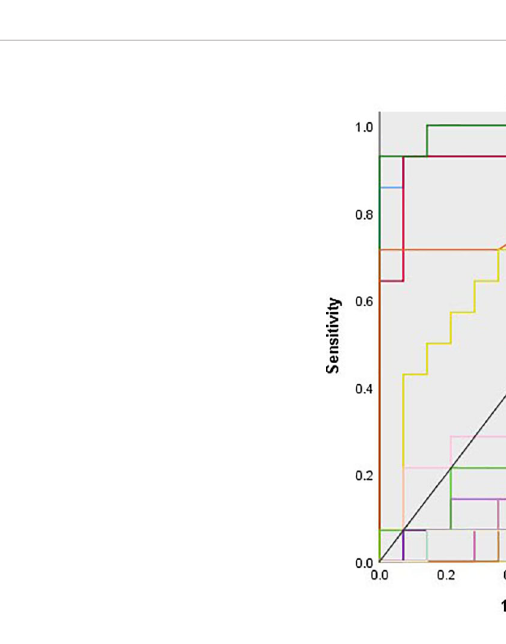
FIGURE 4 | Receiver operating characteristic (ROC)